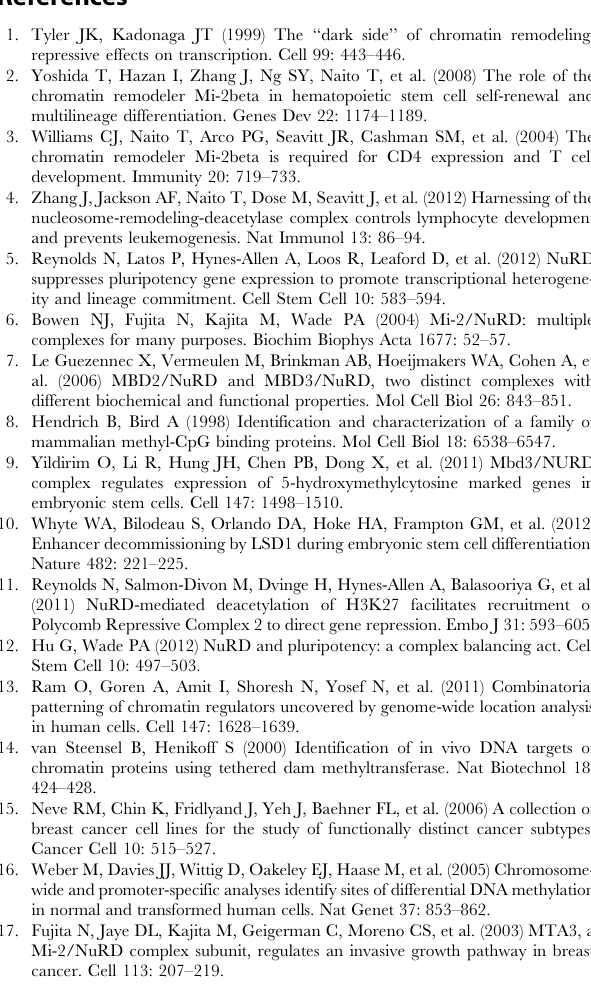
Figure S5 Validation of MBD3 knockdown in MCF-7 cells. Western blot shows MBD3 expression levels in control (shLuc) and MBD3 knockdowned cells. Histone H3 is used as a loading control. (TIF) Figure S6 MBD3 impacts nucleosome density at bound promoters and gene bodies. TSS’s were binned into 4 equal sized bins by MBD3 occupancy level. Nucleosome position and density were plotted as described in Methods using data derived from control (shLUC) and MBD3 depleted (shMBD3) cells. (TIF) Table S1 Gene set enrichment in cell-type specific MBD3 DamID peaks. Table S2 DamID vs ChIP-seq peaks comparison. Peak overlap between DamID and ChIP-seq was calculated with chromosome bound circular permutation method (see Methods). Table S3 Gene set enrichment in cell-type specific MBD3 ChIP- seq peaks. Table S4 Quality control of MNase-seq data. (XLSX)